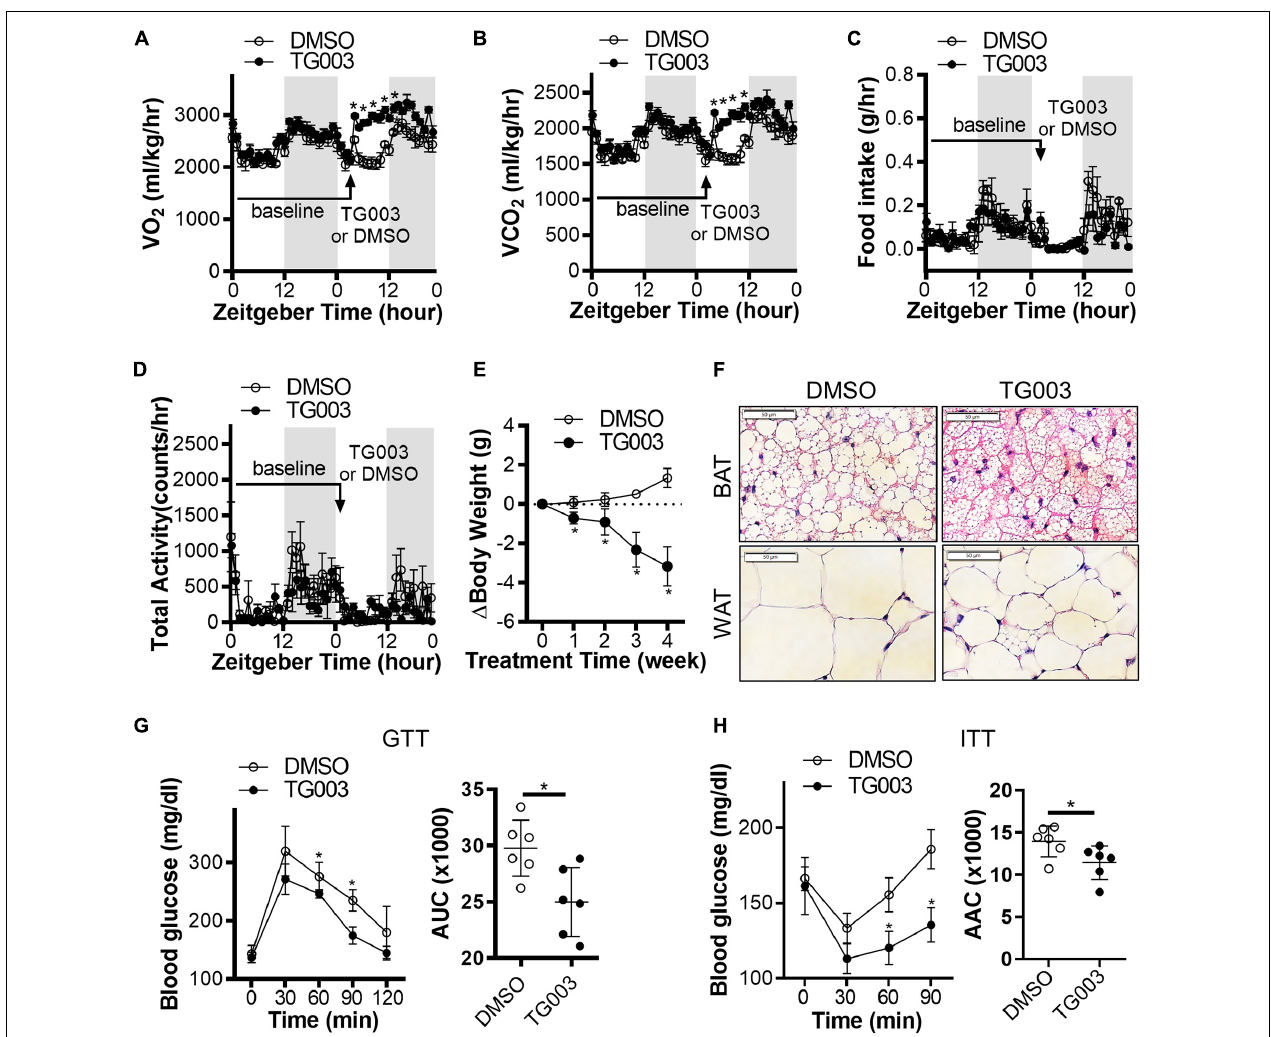
FIGURE 7 | Inhibition of CLK improves insulin sensitivity in obese mice. (A–D) Diet induced obesity (DIO) in male C57BL/6J mice was induced by high-fat diet (HFD) for 24 weeks starting at 6 weeks of age, at 22 ◦ C. Energy expenditure in obese mice was measured at baseline for 24 h after 24 weeks of HFD feeding. After subcutaneous injection one bolus of CLK inhibitor TG003 (50 µ g/kg) or vehicle control DMSO (black arrow), the energy expenditure was measured for another 24 h. Gray area indicates the light-off period. n = 5 mice/group. Data shown as mean ± SEM. * p < 0.05 vs DMSO. (One-way ANOVA with Sidak’s multiple comparisons test). (E) After the energy expenditure measurements in panels (A–D) , the DIO mice continued the HFD feeding while being treated with TG003 (50 µ g/kg) or DMSO (subcutaneous injection, once a day) for an additional 4 weeks. The body weight change of mice was calculated by subtracting the body weight on the first day of TG003 or DMSO treatment from that of each week of TG003 or DMSO treatment. n = 6 mice/group. Data shown as mean ± SEM. * p < 0.05 vs DMSO. (One-way ANOVA with Sidak’s multiple comparisons test). (F) H&E staining of the interscapular brown adipose tissue (BAT) and subcutaneous white adipose tissue (WAT), scale bar, 50 µ m. (G,H) The oral glucose tolerance test (G) and insulin tolerance test (H) , at the end point of HFD feeding and TG003 or DMSO treatment as described in panel (E) . Histograms show the corresponding areas under the curves (AUC) of GTT and areas above the curves (AAC) of ITT. n = 6 mice/group. Data shown as mean ± SD. * p < 0.05 vs DMSO. [One-way ANOVA with Sidak’s multiple comparisons test for the curves in panels (G,H) and unpaired Student’s t test for histograms in panels (G,H)